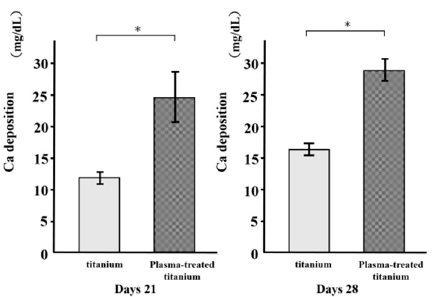
Figure 10. Calcium deposition of titanium and plasma-modified titanium. Mineralization was greater in the cells on the plasma-treated specimens than the untreated titanium disk.